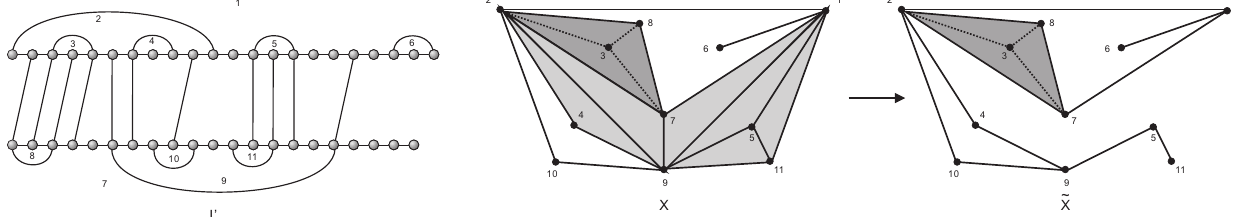
Figure 4. Simplicial collapse. LHS: A τ -structure I (cid:48) in which each φ -arc is incident to at most one arc. RHS: X , the complex of I (cid:48) and ˜ X . The underlying sequence of elementary collapses that generates ˜ X is given by ( { 1,5,11 } , { 1,11 } ) , ( { 5,9,11 } , { 9,11 } ) , ( { 1,5,9 } , { 1,5 } ) , ( { 1,7,9 } , { 1,9 } ) , ( { 2,7,9 } , { 7,9 } ) and ( { 2,4,9 } , { 2,9 } ) . The distinguished empty tetrahedron (darker gray level and dashed lines) cannot be eliminated by simplicial